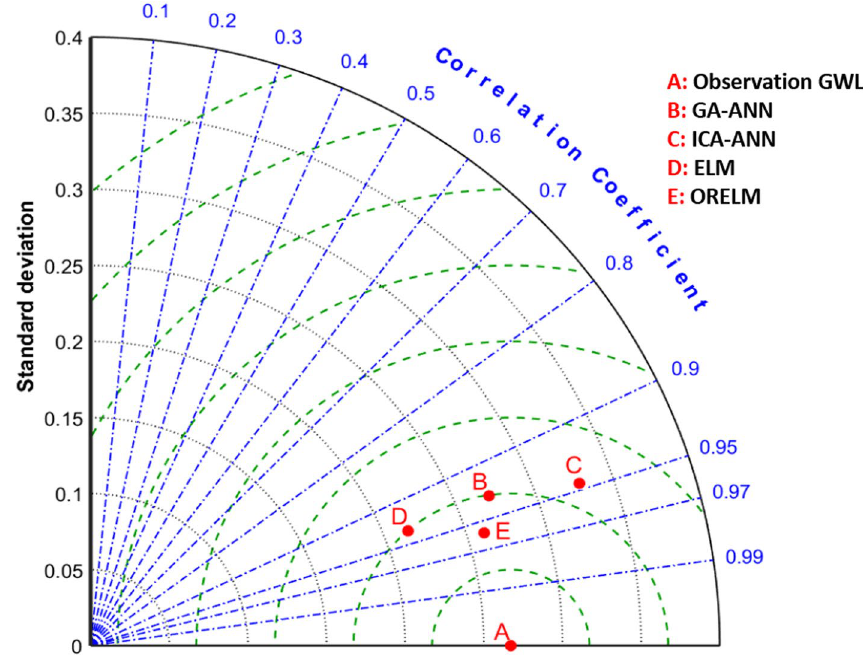
Fig. 8 Taylor diagram for choosing the best artificial intelligence model in modeling test